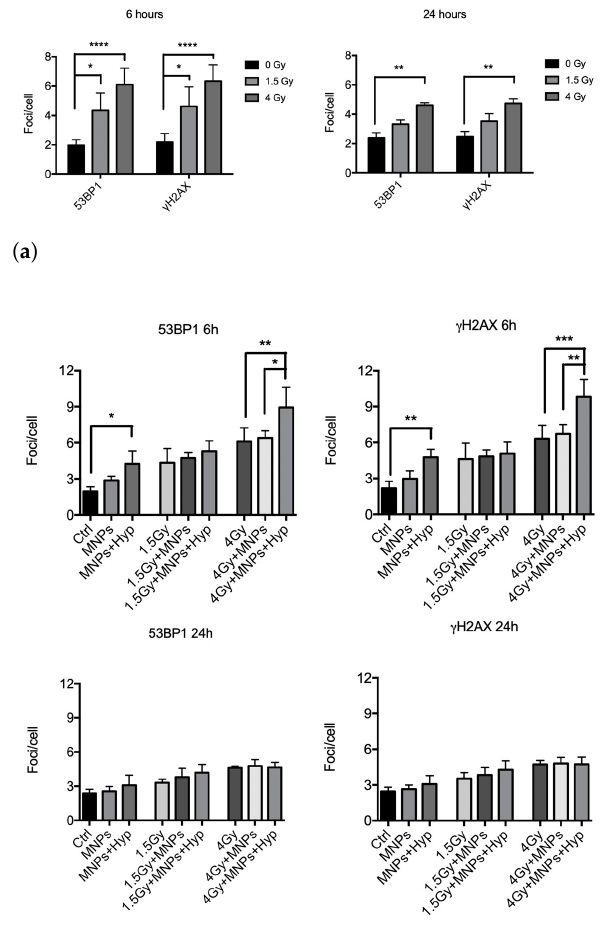
Figure 5. Analysis of 53BP1 and γ -H2AX foci induction after 6 h and 24 h, in BxPC3 pancreatic tumor cells, from: ( a ) the exposure to 1.5 and 4 Gy of proton irradiation alone; ( b ) the same proton irradiation in combination with MNP uptake and/or Hyp. * indicates p -value p < 0.05, ** indicates p < 0.01, *** indicates p < 0.005, **** indicates p < 0.0001 (one-way ANOVA and Tukey’s multiple comparison